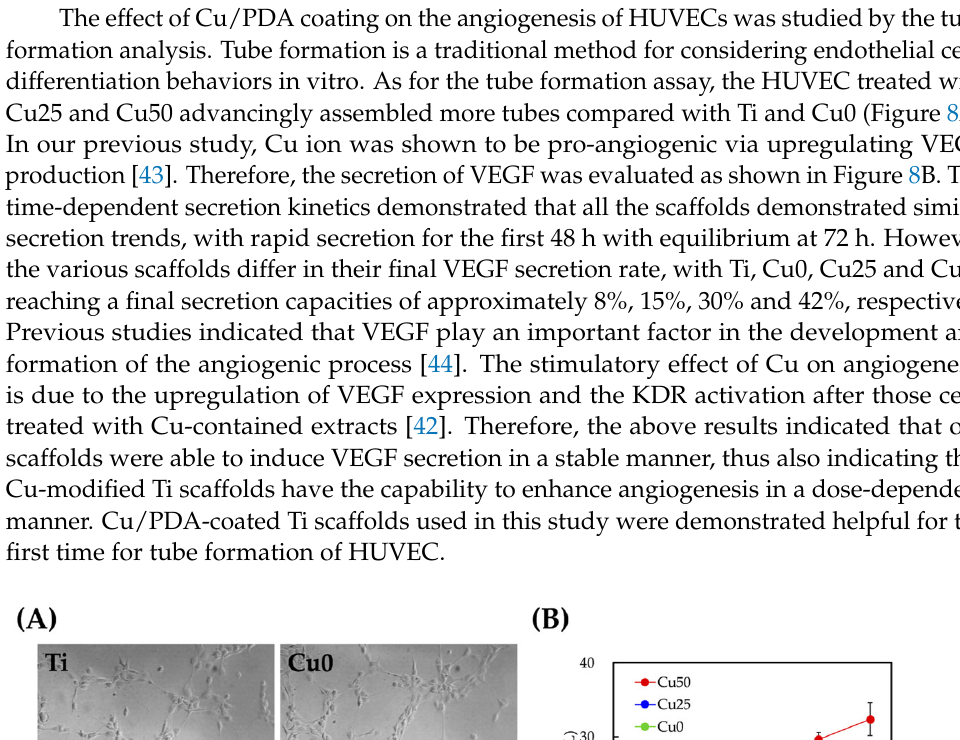
Figure 7. The concentration of Cu released from the scaffolds immersed in medium. Data presented as mean ± SEM, n = 6 for each group.